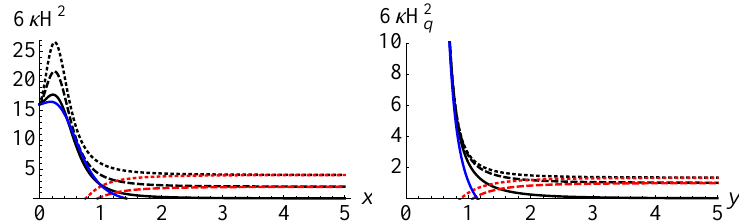
Figure 1. The squared Hubble rate of the physical metric ( left ) and the auxiliary metric ( right ) are shown as functions of the rescaled scale factors x and y , respectively. In these figures, we choose a positive κ . The black and red curves correspond to l = 1 and l = − 1, respectively. Within the black and red curves, the solid, dashed, and dotted curves correspond to λ = 1, λ = 2, and λ = 3, respectively. Besides, the blue curves exhibit the solutions in which the universe has a smooth bounce between an expanding phase and a contracting phase ( λ = 1/2, l = 1).